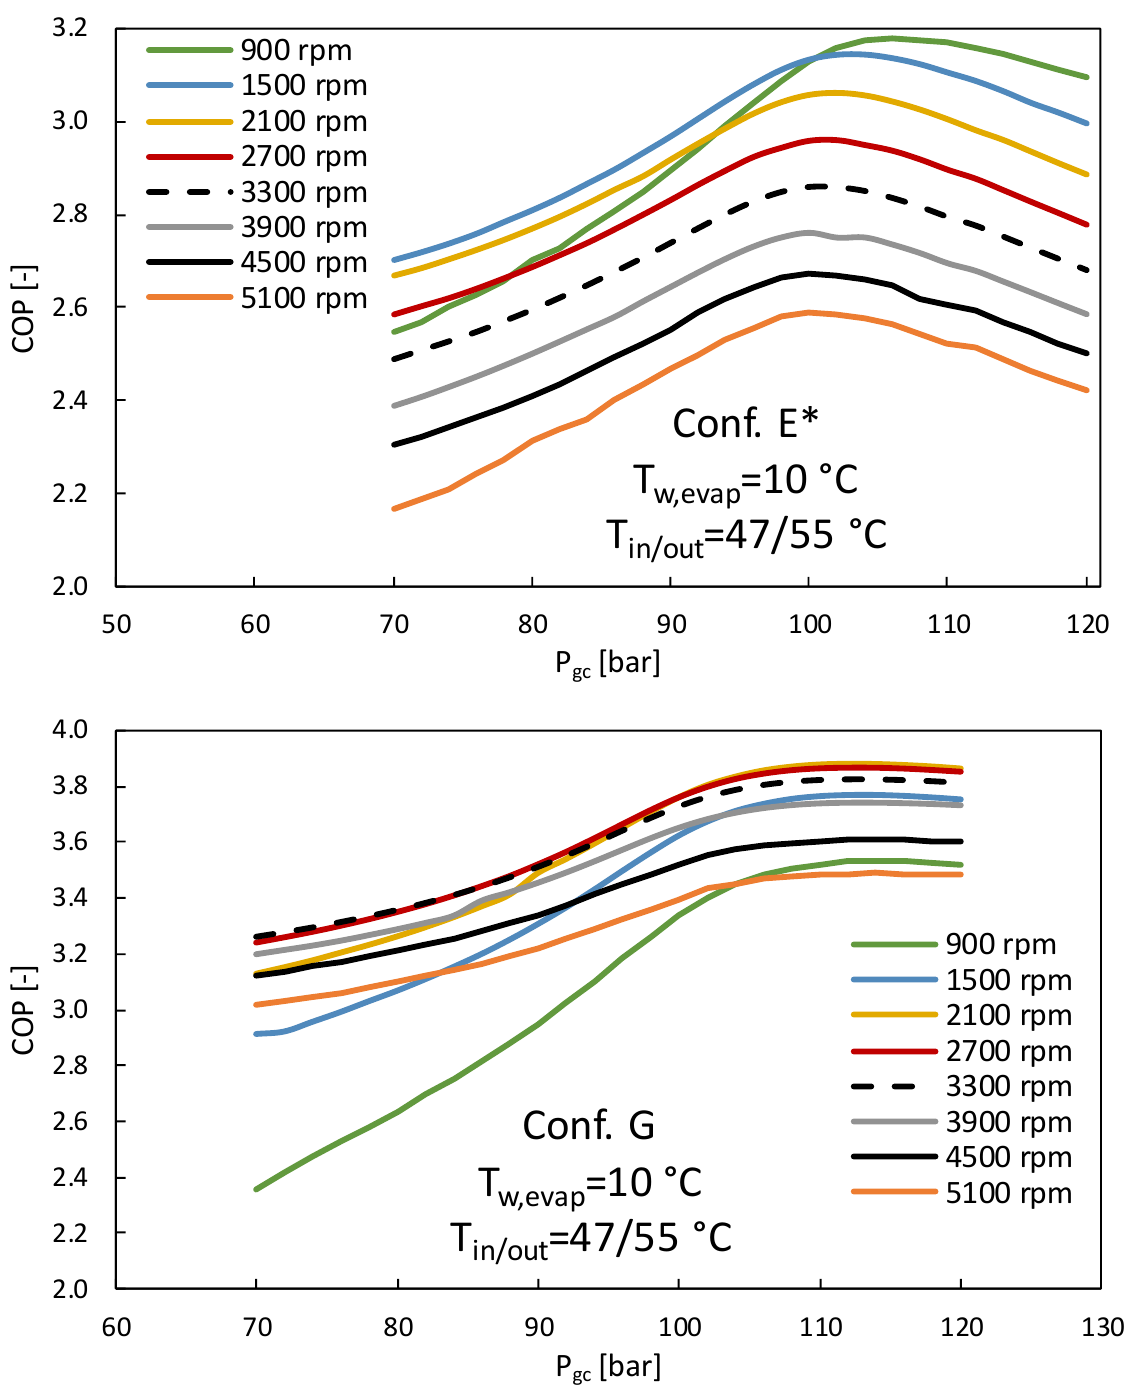
Figure 8. COP vs. gas cooler pressure as a function of the compressor speed for the case 47/55 °C for configurations Conf. E* ( up ) and Conf. G ( down ).